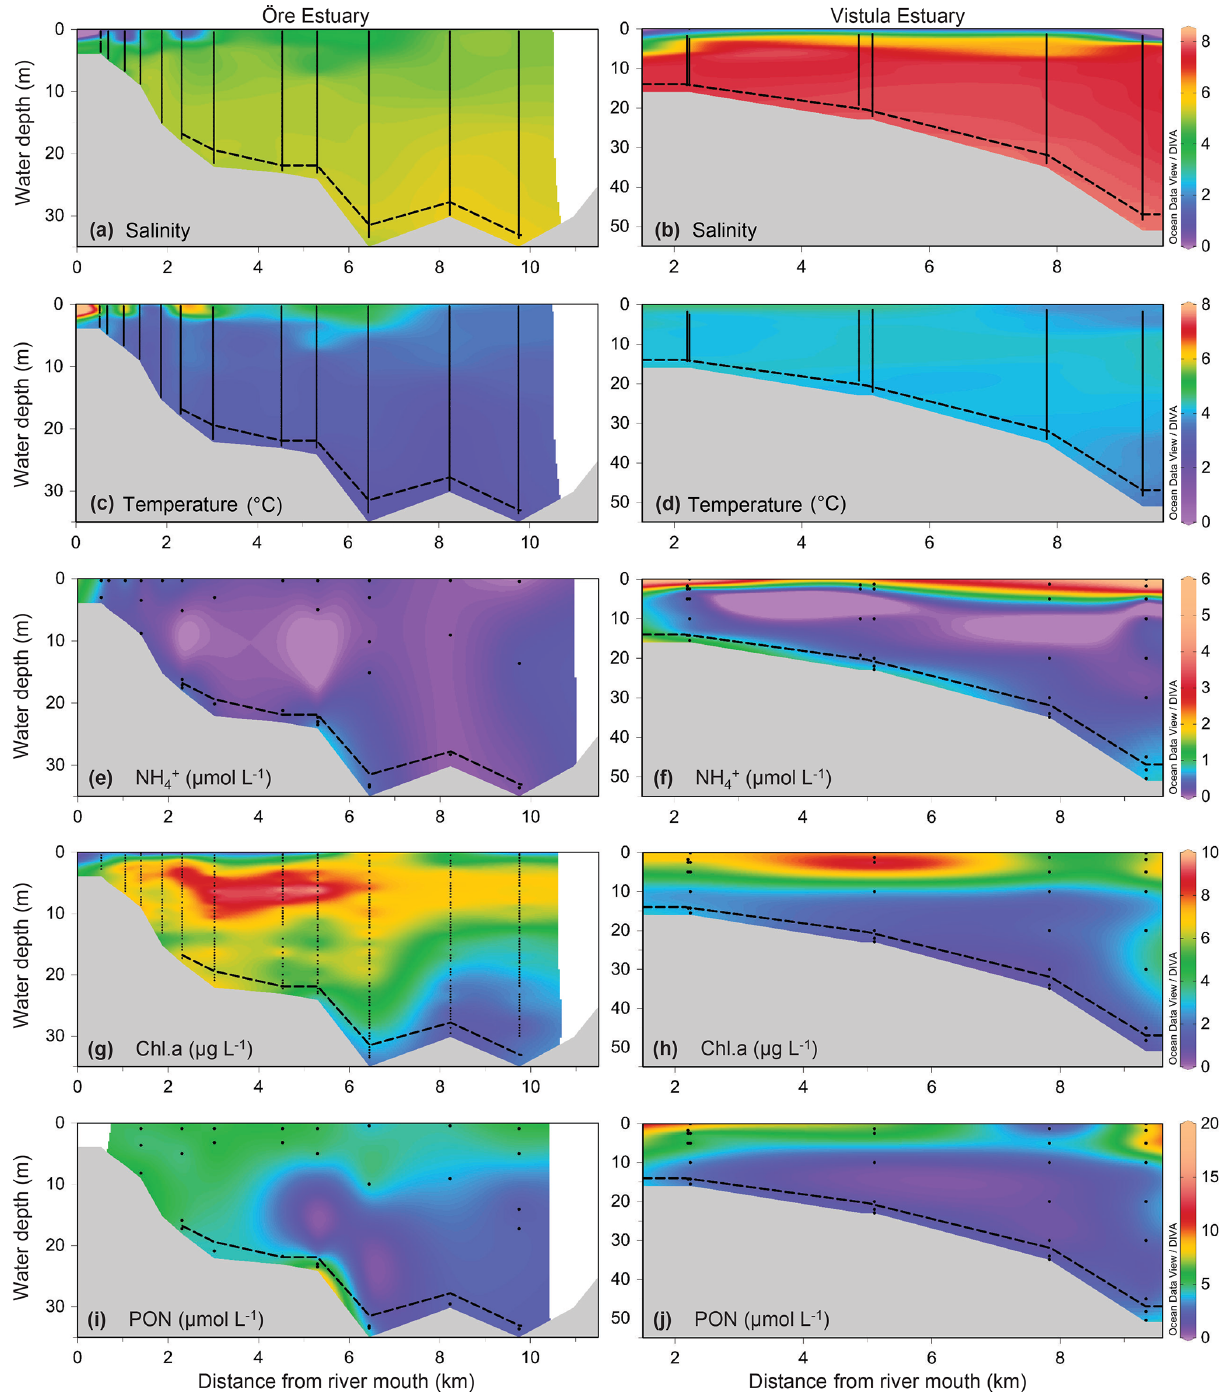
Figure 2. Environmental variables of the water column along a sampling transect (vertical points) from the river mouth to the outlets of the Öre (left) and Vistula (right) estuaries in spring. Note that, due to different optical properties of the water and different measurement methods, the Chl a concentrations are not directly comparable between the two estuaries; rather, the figures provide qualitative information on the presence or absence of phytoplankton. Bottom topography was estimated from the water depths of the stations. The dashed line represents the vertical extent of the BBL (see Sect. 2.1.1). The plots were derived from 12 (Öre Estuary) and 6 (Vistula Estuary) profiles using DIVA-gridding in Ocean Data view (Schlitzer, 2015). Plots of salinity, temperature, and PON in the Öre Estuary are reproduced from Hellemann et al.